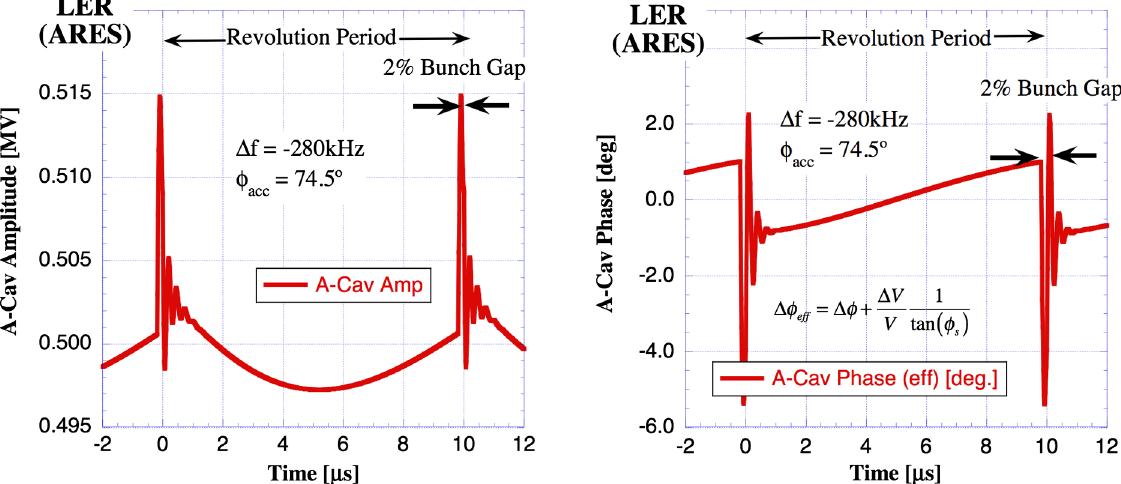
FIG. 7. Simulation results of the amplitude (left) and phase (right) modulation due to the 2% bunch gap in ARES. The calculations are done for LER at SuperKEKB.